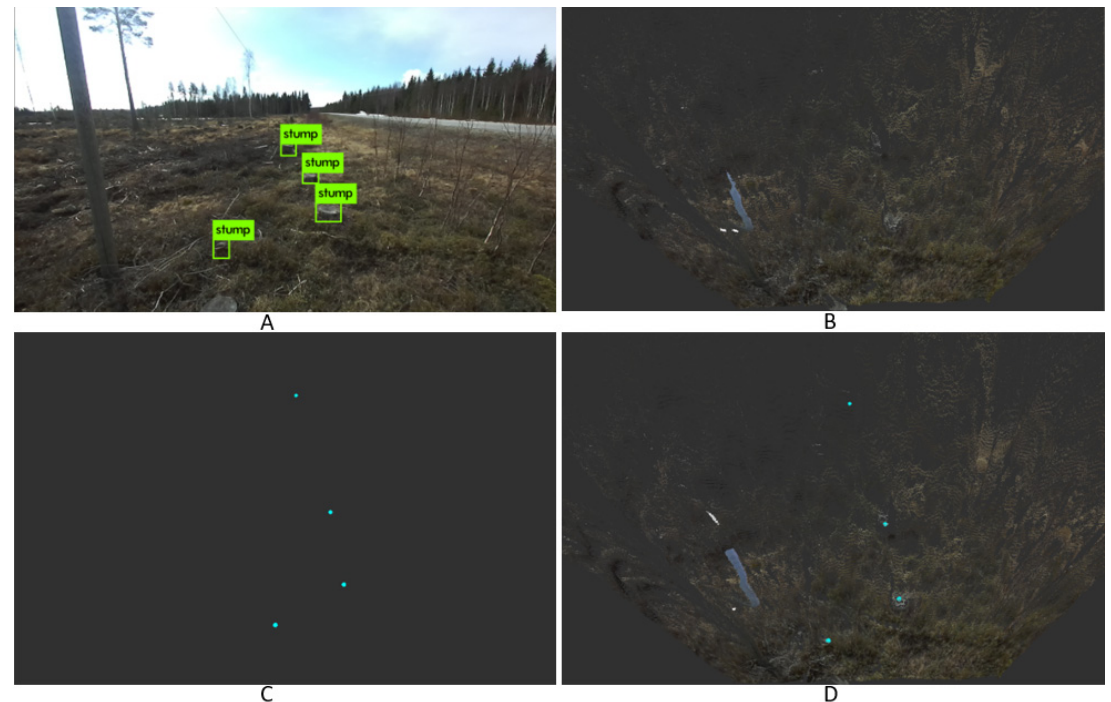
Figure 6. ( A ) The display of image detection; ( B ) isometric display of the scene as point cloud; ( C ) isometric display of object center points; ( D ) the combination of ( B , C ).